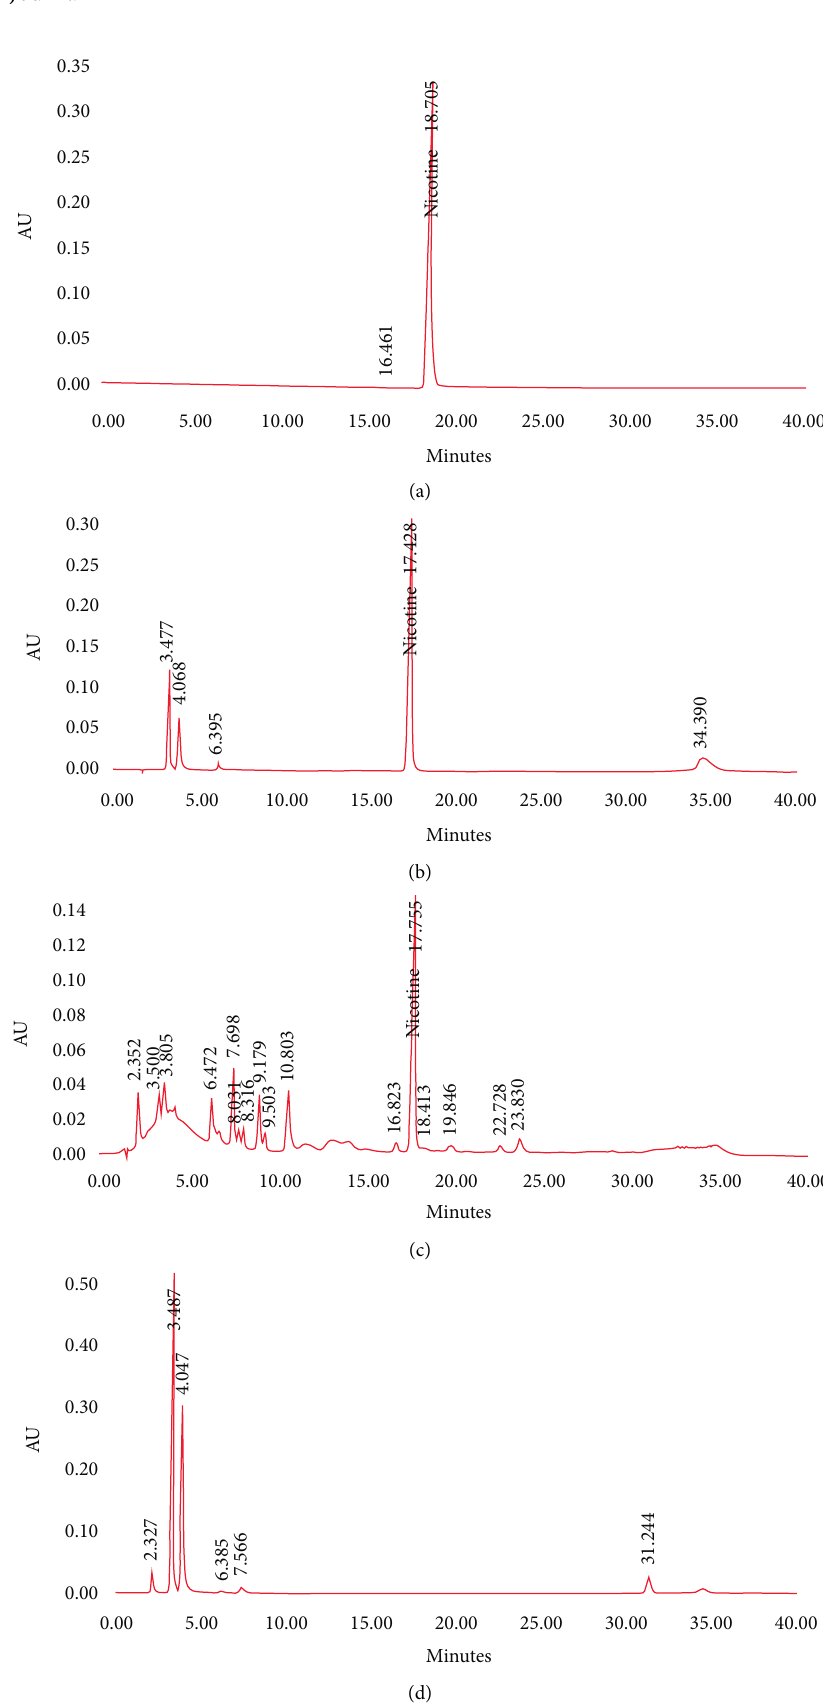
Figure 1: Example of chromatograms: (a) chromatogram A, (b) chromatogram B, (c) chromatogram C, and (d) chromatogram